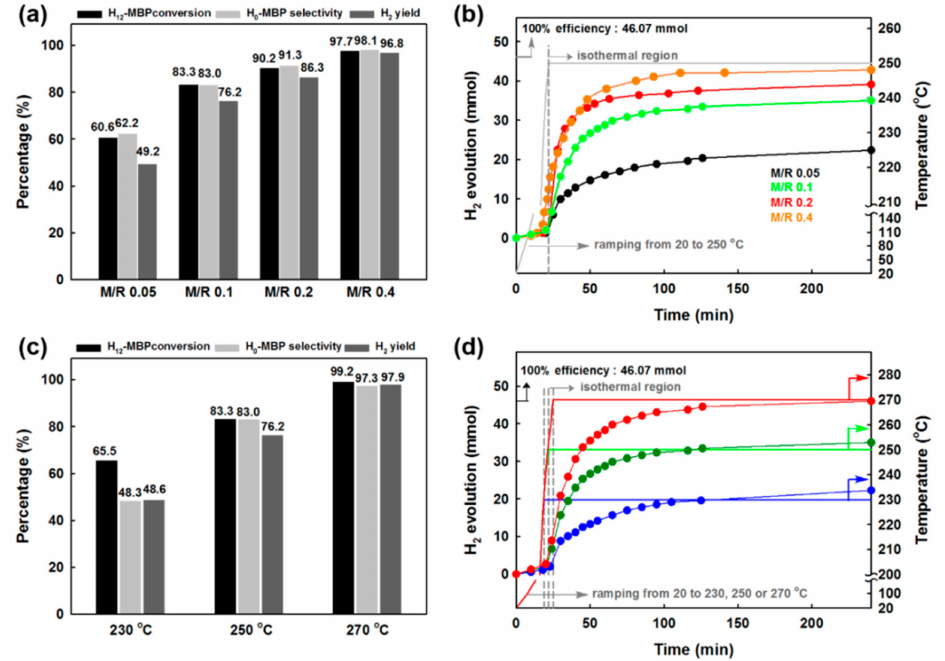
Figure 11. ( a ) Activity results obtained by GC; ( b ) time-dependent H 2 release curves of the MPdA600_1h catalyst with change in M / R ratio at 250 ◦ C and 4 h; ( c ) Activity results obtained through GC; ( d ) time-dependent H 2 release curves of the MPdA600_1h catalyst with change in temperature at M / R ratio of 0.1 mol% and 4 h in the dehydrogenation of H 12